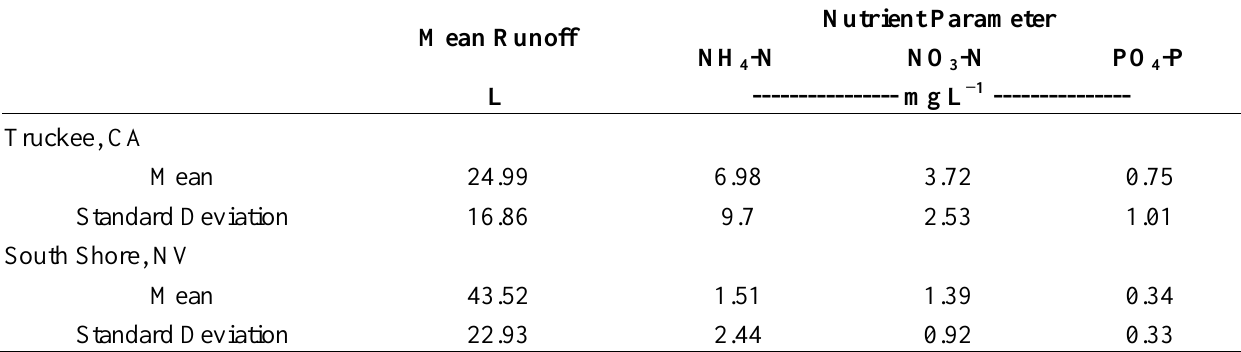
Table 3. Mean cumulative overland/litter interflow runoff 1 and concentrations of inorganic N and P from Dec 2001 through Jul 2003 from study plots near Truckee, CA and South Shore Lake Tahoe,